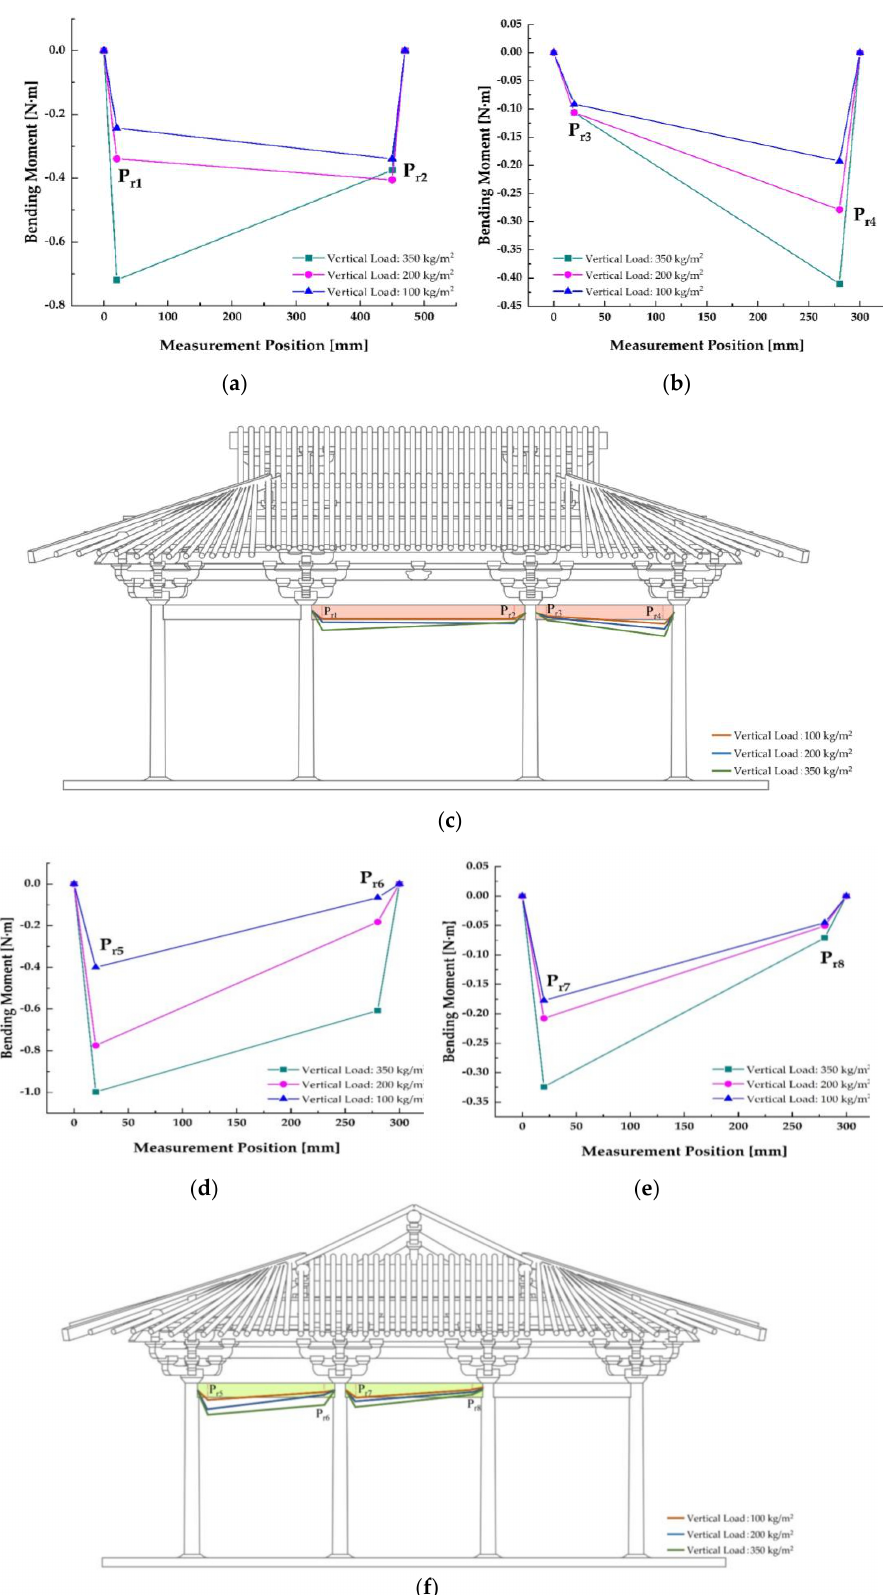
Figure 14. Bending moment and deflection location illustration of components. ( a – c ) Frontal Lan’E. ( d – f ) Lateral Lan’E (P r1 –P r8 in the graph indicate the attached position of strain